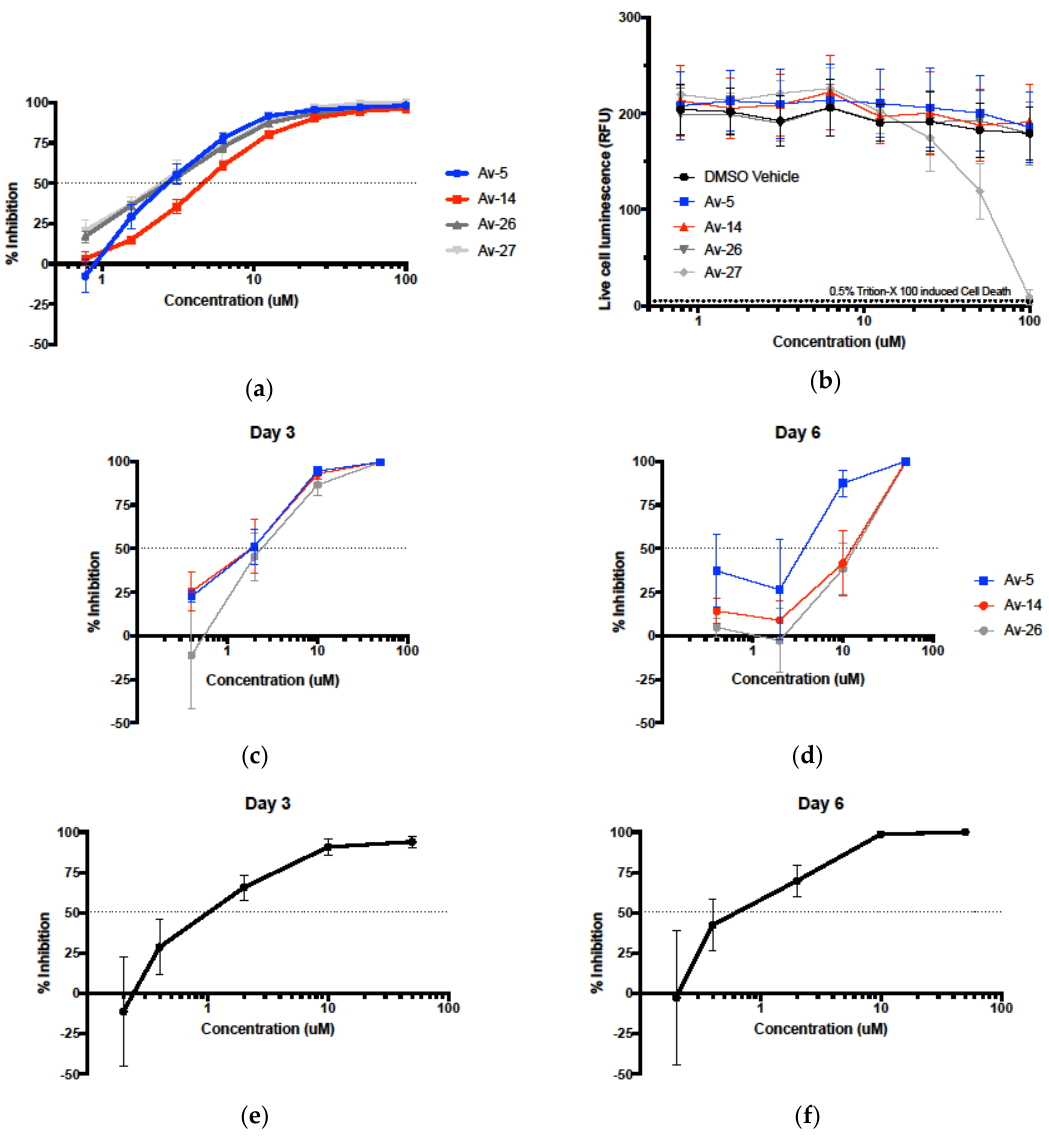
Figure 2. Antiviral activity and cytotoxicity of Avirulin lead compounds. ( a ) Lead compounds Av-5, Av-14, Av-26, and Av-27 were evaluated using a TZM-bl luciferase assay at a concentration range of 0.78 to 100 µM, for determination of IC 50 and IC 90 ( n = 8). ( b ) Cytotoxicity of lead Avirulins towards TZM-bl was determined using a luminescence-based cytotoxicity assay, CytotoxGlo. Proteases released from dead cells cleaved a luminescent substrate, producing luminescence. Luminescence was normalized to total cell number by complete cell lysis with detergent. Av-27 was excluded at this point due to cytotoxicity. Avirulin lead compounds with low cytotoxicity, Av-5, Av-14, and Av-26 were used to treat BaL infected PM1 cells, an immortalized line of T lymphocytes ( c , d ). Based on its high activity and low cytotoxicity, Av-5 was selected to treat peripheral blood mononuclear cells (PBMCs) ( e , f ) isolated from healthy human subjects. PM1s and PBMCs were treated with Avirulins, then incubated with BaL for 1.5 h, followed by drug retreatment and incubation. Cell supernatants were collected on days 3 and 6 post infection, and cells were resuspended in fresh media with new drug on day 3 following infection to evaluate prolonged inhibition. Viral inhibition was determined by comparison of ng/million cells of the viral protein p24, detected by enzyme linked immunosorbent assays (ELISA) in cell supernatant of DMSO vehicle vs. drug treatment. PM1s: n = 4, PBMCs: n = 4, error = standard error of the mean (SEM).